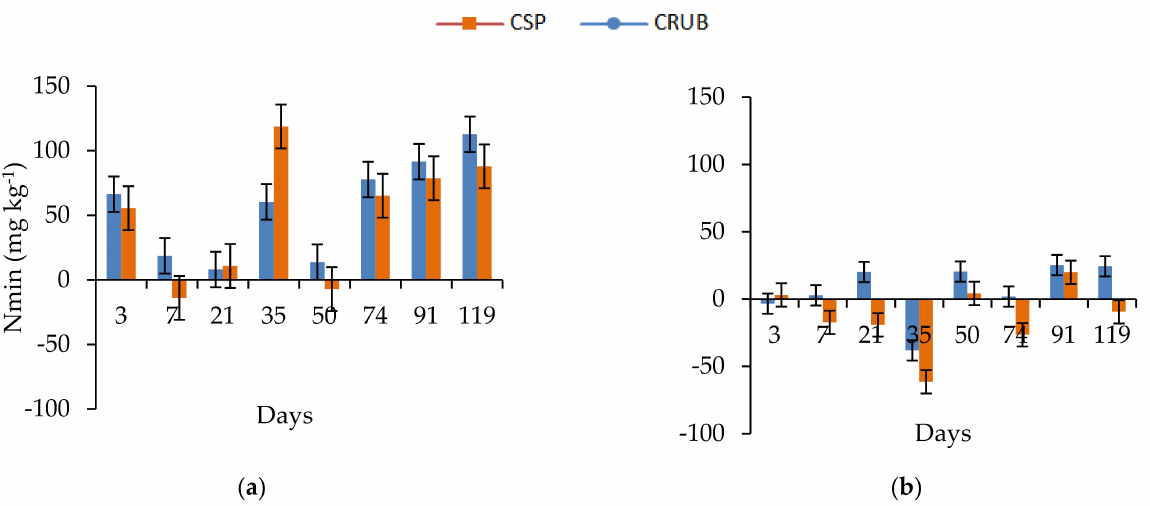
Figure 3. Potential net mineralized N (Nmin). ( a ): S1; ( b ): S2. CSP: poultry manure and wheat straw; CRUB: biosolids and wood shavings. Bars represent standard